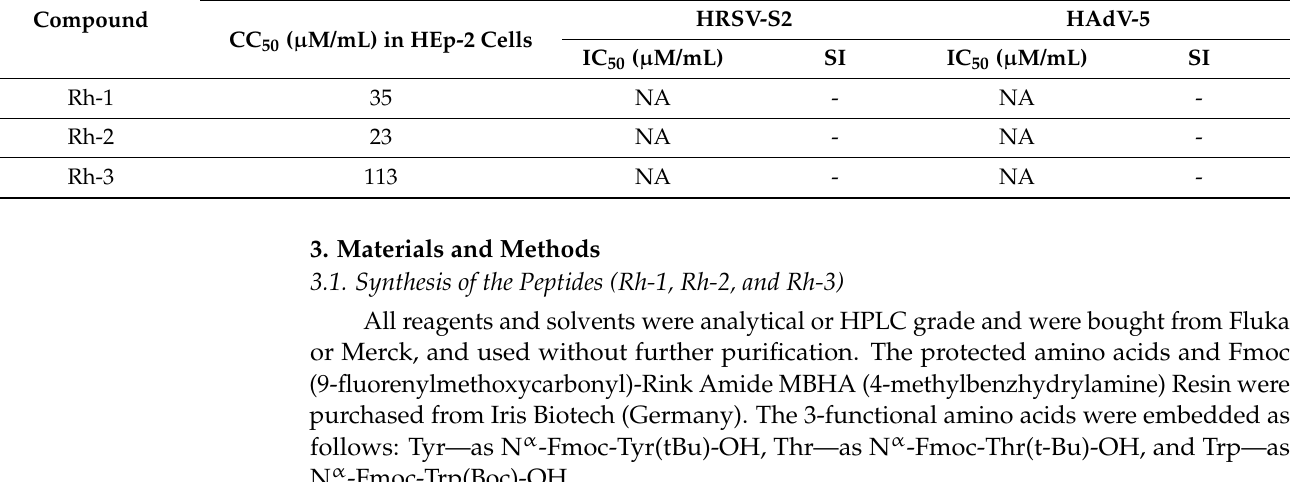
Table 4. Cytotoxicity and antiviral activity of new rhodamine-peptides against human respiratory syncytial virus (HRSV-S2) and Human adenovirus C serotype 5 (HAdV-5) in HEp-2 cell culture. Cytotoxicity Antiviral Compound